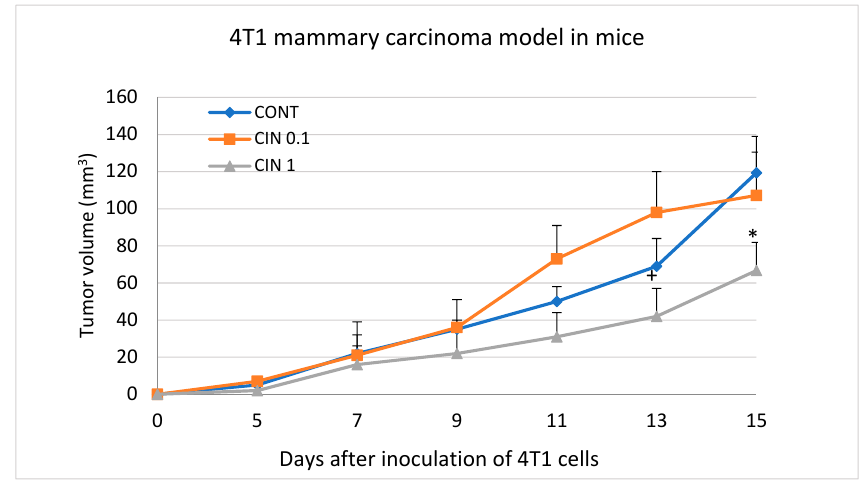
Figure 2. Tumor volume of mouse 4T1 mammary adenocarcinomas during the experiment. Data are expressed as mean ± SEM. Significant di ff erences: * p < 0.05 vs. CONT, + p < 0.05 vs. CIN